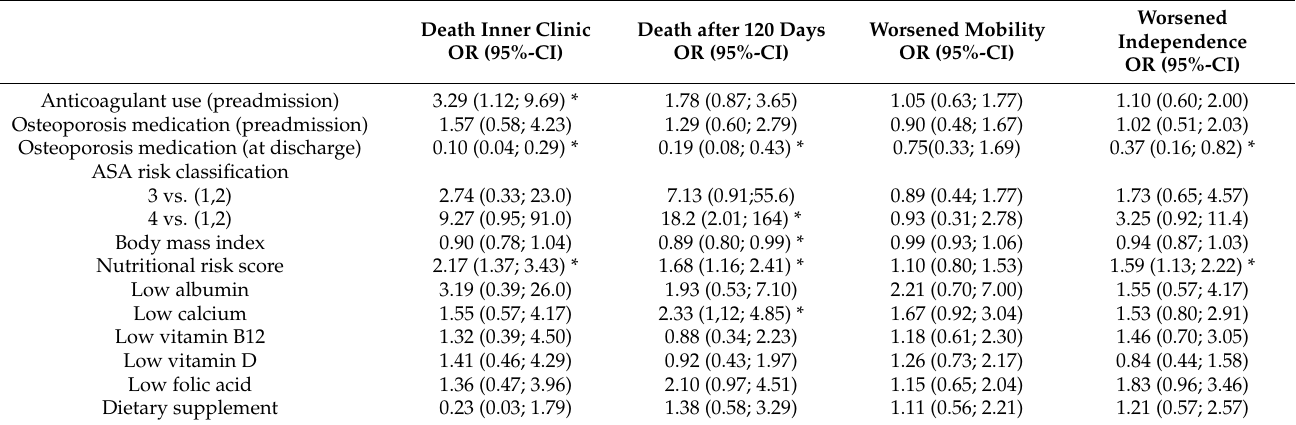
Table 4. Results of regression analysis of risk factors. Death Inner Clinic OR (95%-CI)